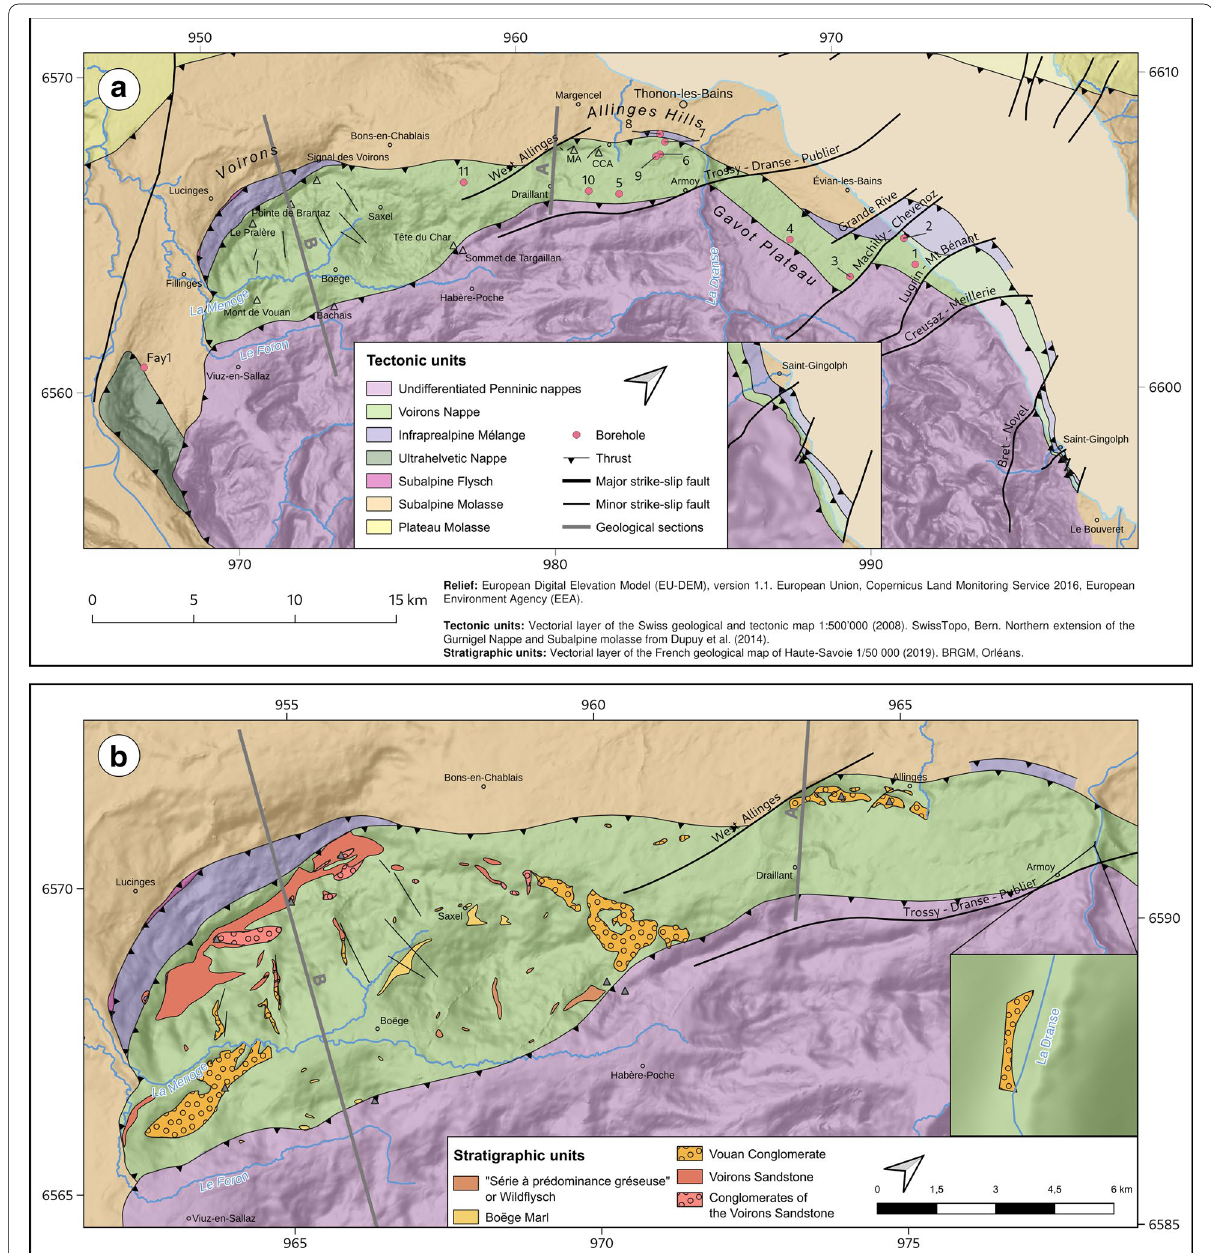
Fig. 2 Geological overview of the Voirons Nappe. a Tectonic map of the Voirons Nappe and its relation with the surrounding units, with the location of boreholes and of the geological sections depicted in Fig. 3. Inset: close‑up on the Saint‑Gingolph area. b Geological map of the Voirons Flysch based on the Annemasse sheet (Kerrien et al. 1998) and the Douvaine sheet (Olive et al. 1987) of the French Geological map. Inset: close‑up on the Dranse outcrop. MA: La Maladière; CCA: Colline des Châteaux des